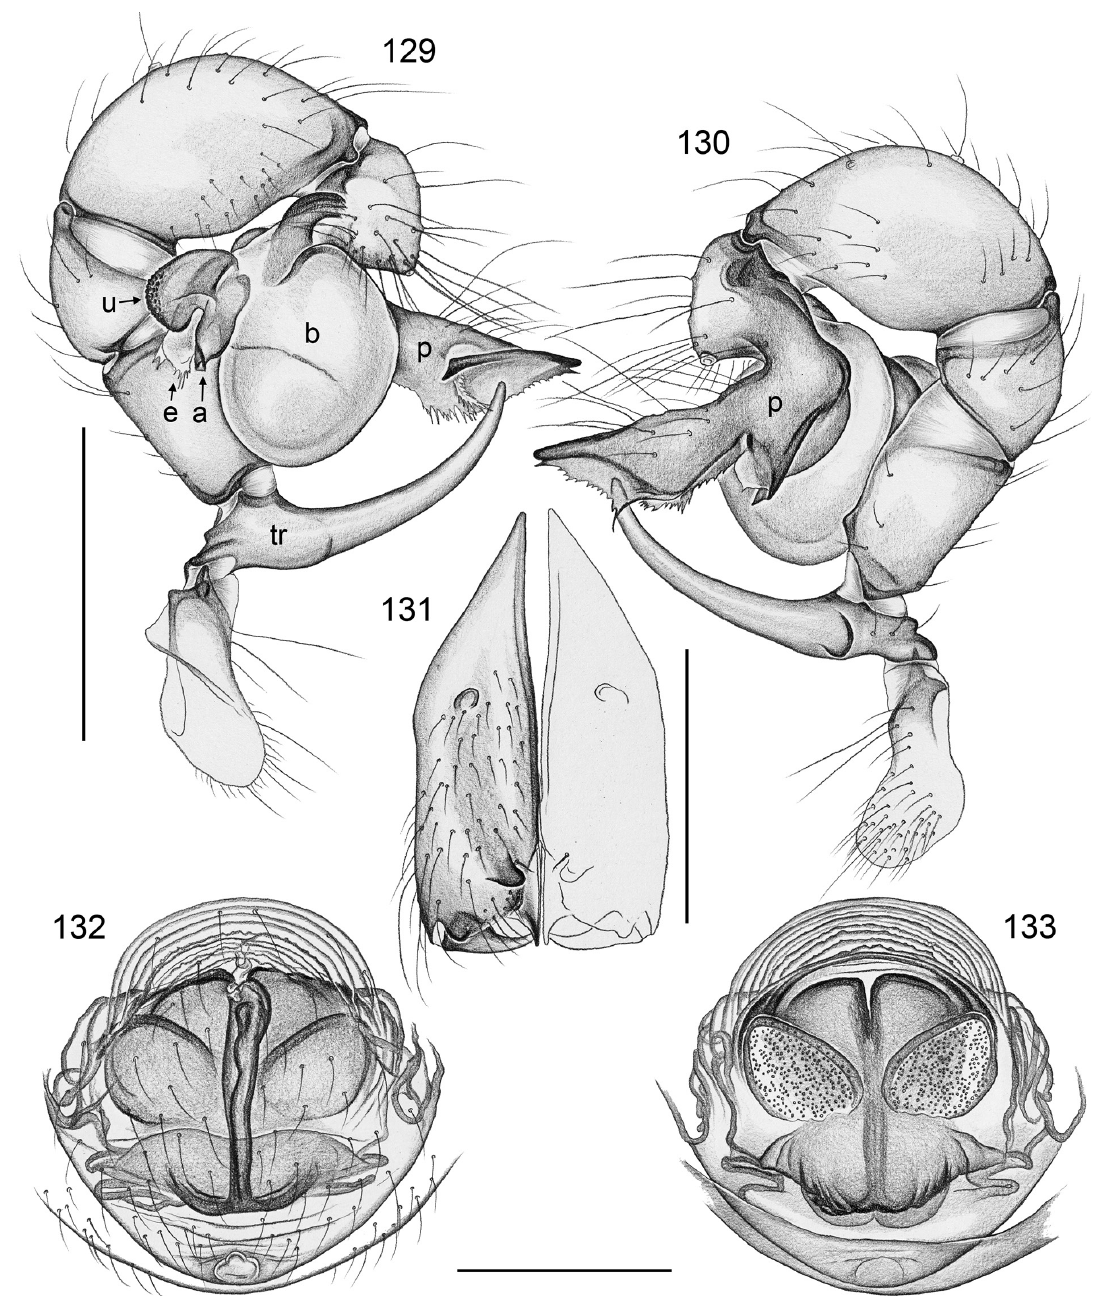
Figs 129–133. Pholcus kipungit Huber, sp. nov., ZFMK Ar 15042. 129–130 . Left male palp, prolateral and retrolateral views. 131 . Male chelicerae, frontal view. 132–133 . Cleared female genitalia, ventral and dorsal views. Abbreviations: a = appendix; b = genital bulb; e = embolus; p = procursus; tr = trochanter; u = uncus. Scale lines: 0.3 mm (131–133), 0.5 mm